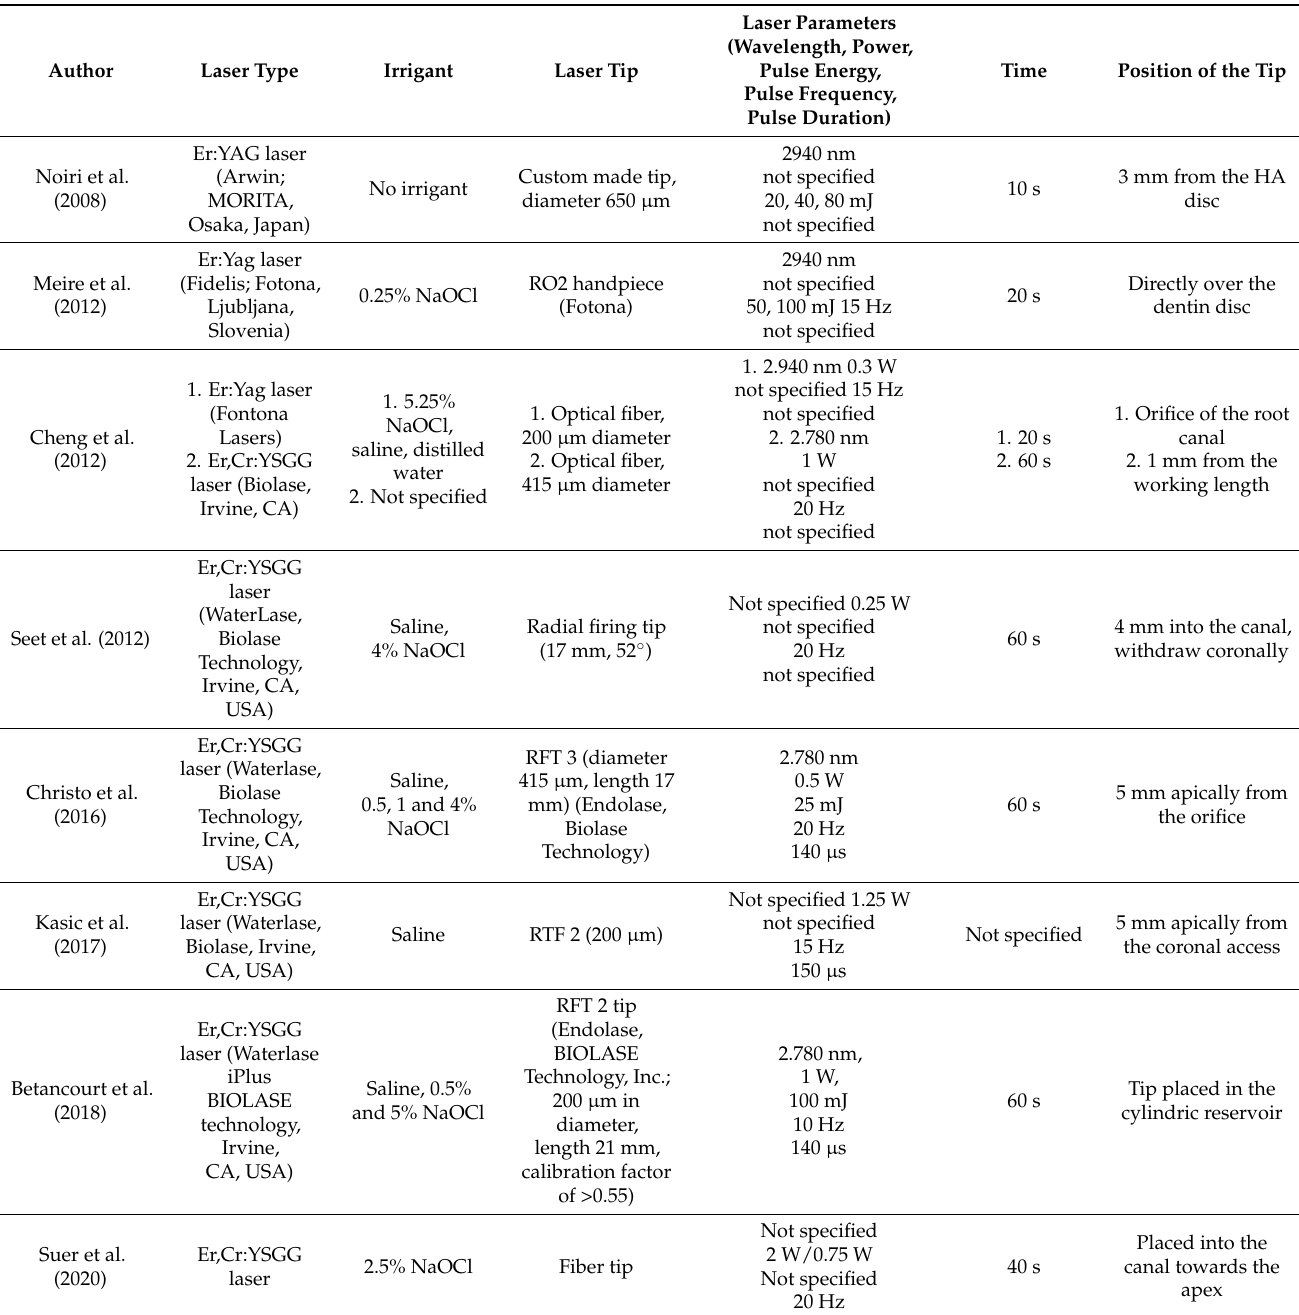
Table 4. Details on laser type, irrigant, laser tip design and parameters, time of irradiation and position of the tip used for biofilm removal in the studies included in the